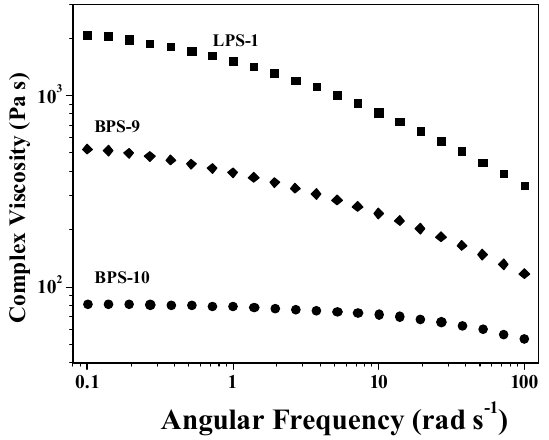
Figure 7. Variation of the complex viscosity with angular frequency of the polymers.